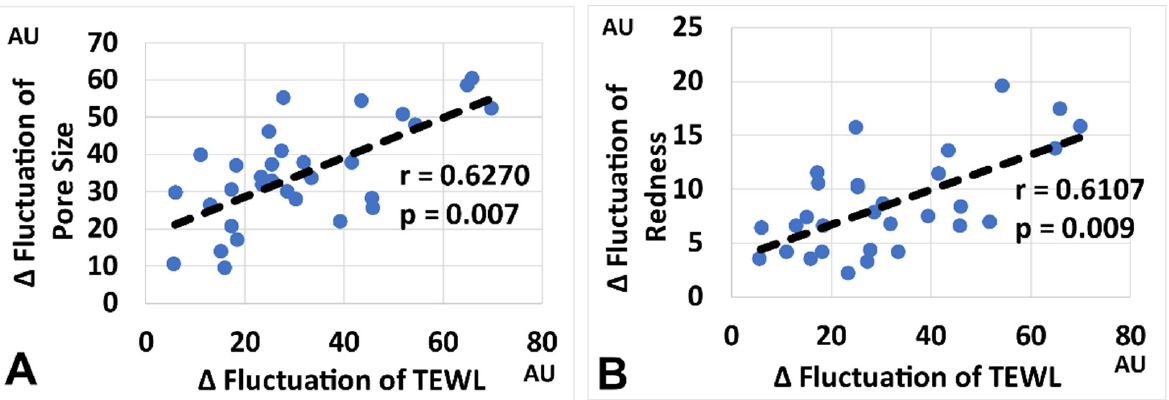
Figure 1. ( A ). Correlation between ∆ fluctuation in TEWL and ∆ fluctuation in pore size. ( B ). Correla- tion between ∆ fluctuation in TEWL and ∆ fluctuation in